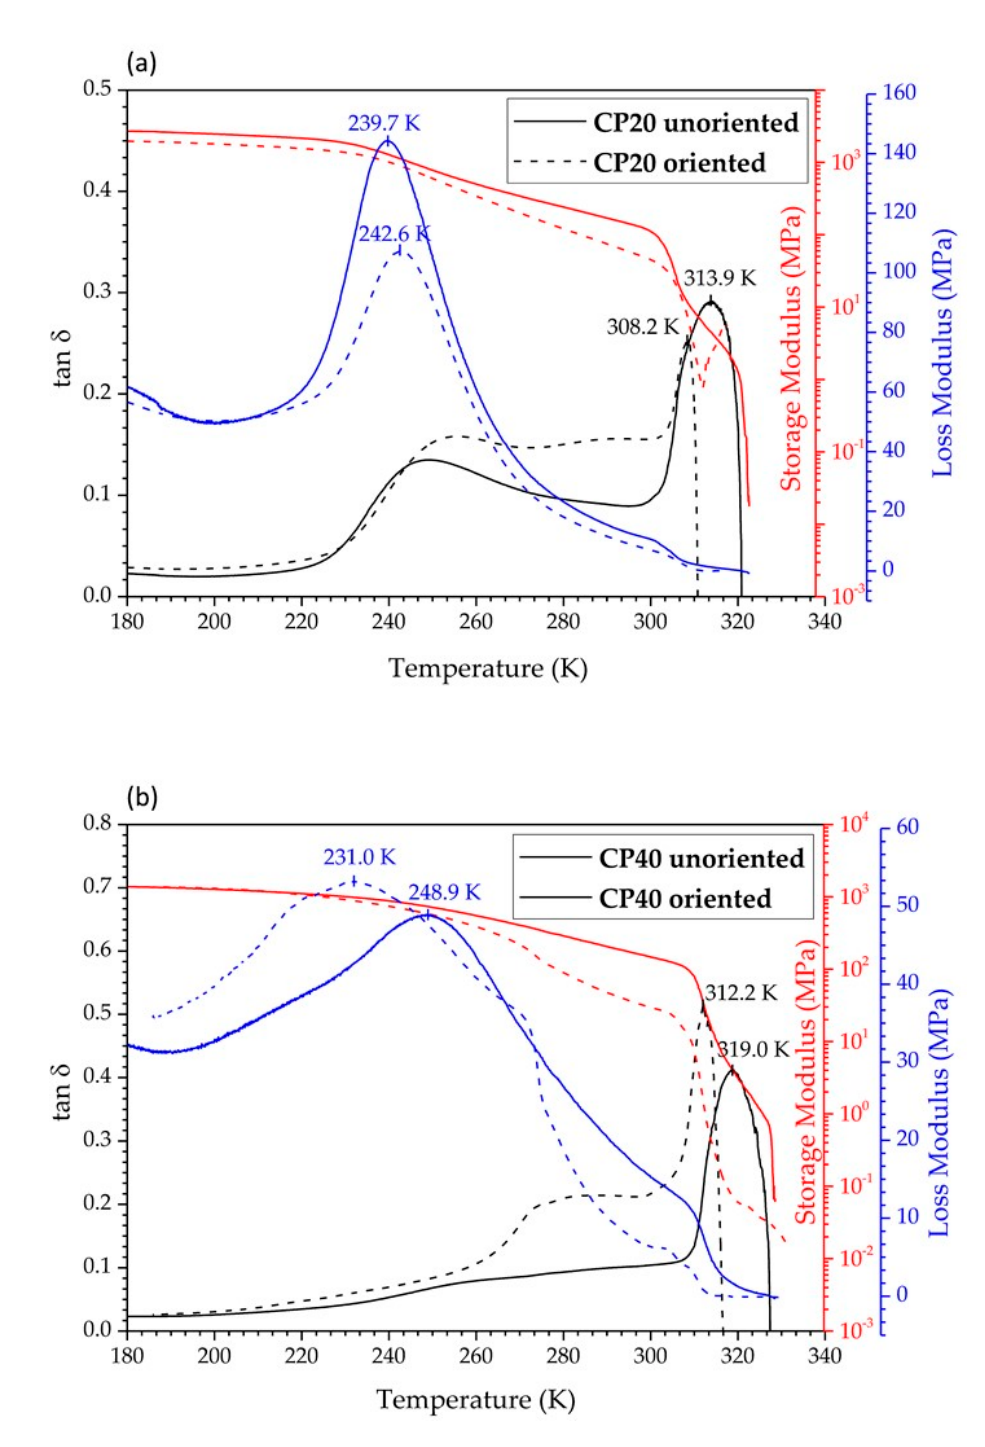
Figure 6. Comparison of DMTA analyses for the CP20 ( a ) and CP40 ( b ) oriented and unoriented samples.